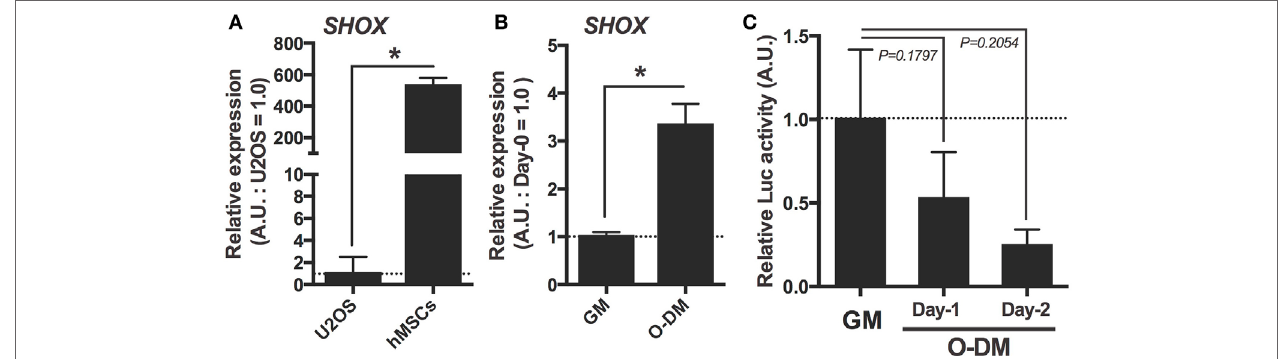
FigUre 3 | Expression and transcriptional activation activity of SHOX in human mesenchymal stem cells (hMSCs) under undifferentiated and under osteogenic differentiation conditions. (a) Quantitative real-time (qRT)-PCR analysis of SHOX gene in U2OS and undifferentiated hMSCs. Data are means of duplicated assays. Data are mean ± SEM, three independent experiments. * P < 0.05. (B) qRT-PCR analysis of SHOX gene in hMSCs under undifferentiated condition for 2 days or osteogenic differentiation condition for 7 days. Data are mean ± SEM, three independent experiments. * P < 0.05. GM: growth medium; O-DM: osteogenic differentiation medium (c) Relative luciferase activities of differentiating hMSCs transfected with luciferase reporter plasmid. At 12 h after transfection, the cells were collected and the luciferase activity was determined. Data are expressed as fold increase over the control group (cells not transfected pLuc-NPPB1940) in each experimental group. Data are mean ± SEM, 2–8 independent